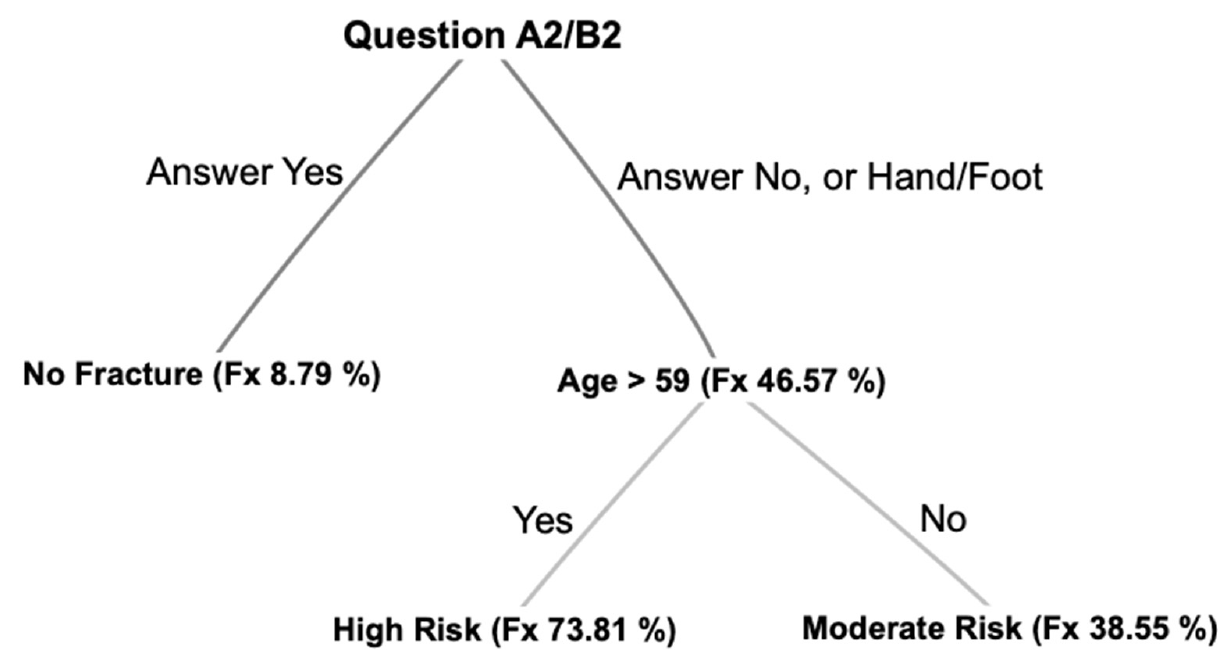
Figure 3. Proposed Figure 3. Proposed heuristic.